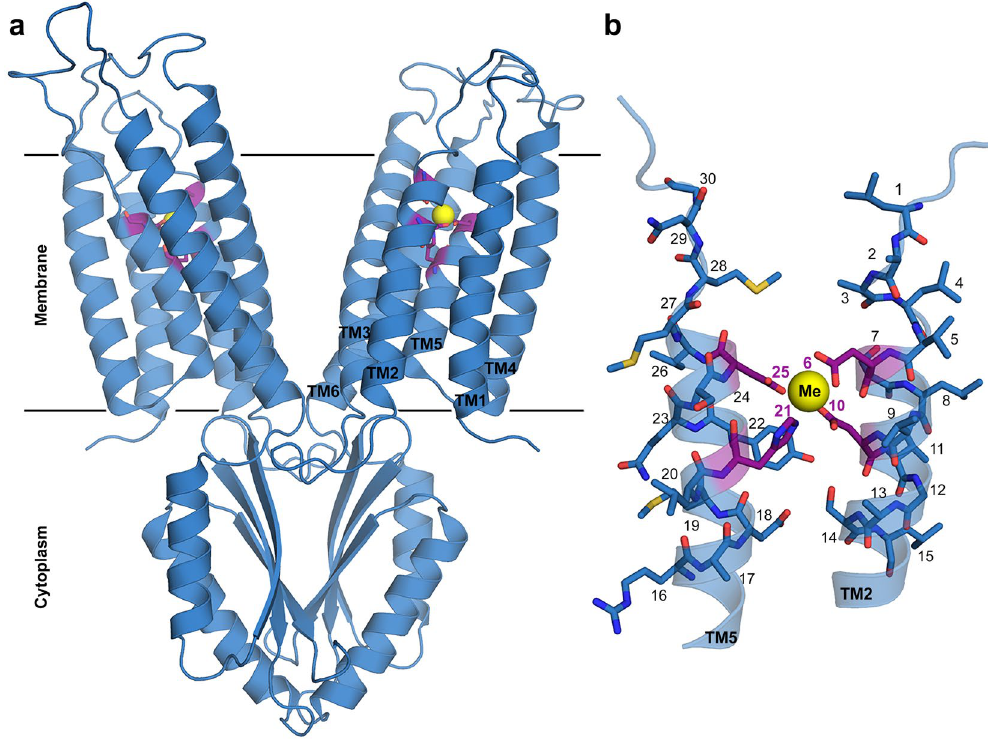
Figure 1. Structure of YiiP A-site. ( a ) Full structure of YiiP (PDB code: 3H90 20 ) with A-site residues represented by purple sticks and Zn by a yellow sphere. ( b ) Magnification of TM2 and TM5 with A-site residues (purple) and their surrounding residues (cerulean blue) presented as sticks and numbered according to the legend of Fig. 5 (the XX-XX quartet residues are numbered as 6, 10, 21 and 25 and the five residues up- and downstream to each X of the XX-XX quartet are numbered respectively). The metal cation is presented as a yellow sphere, nitrogen atoms are in blue, oxygen atoms are in red, sulfur atoms are in yellow and carbons are in purple or cerulean blue. Images were produced using PyMol 49